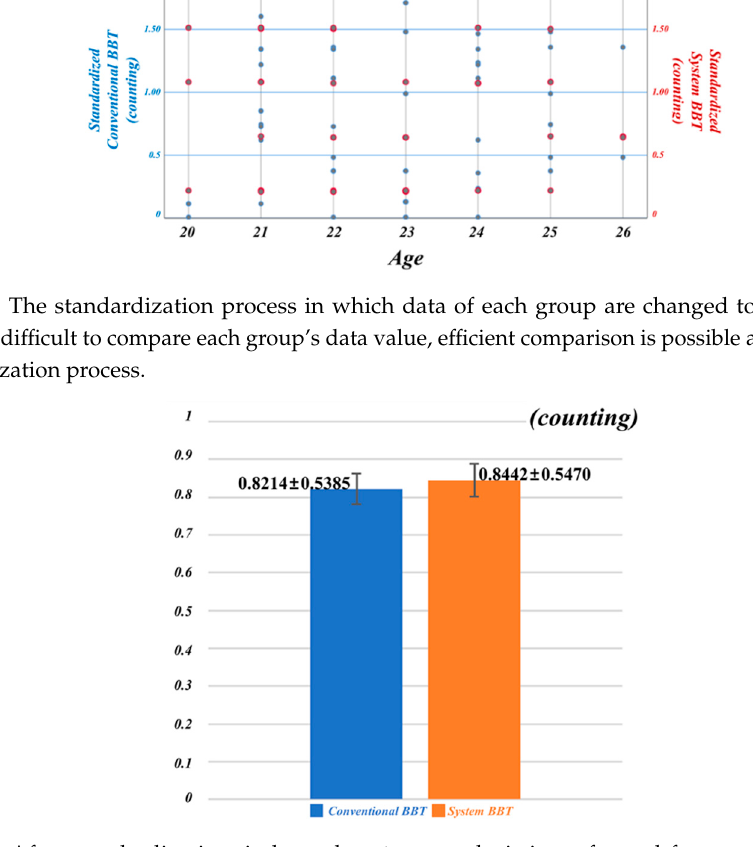
Figure 9. After standardization, independent t-test analysis is performed for mean values of the conventional BBT and system BBT. Data are expressed as mean ± standard deviation (n = 48). Conventional BBT (0.8214 ± 0.5385) and system BBT (0.8442 ± 0.5470) were not statistically significant. Results of this study can be used to analyze a possible home-rehabilitation program and motion pattern recognition at home to show the possibility of objective diagnostic evaluation data.